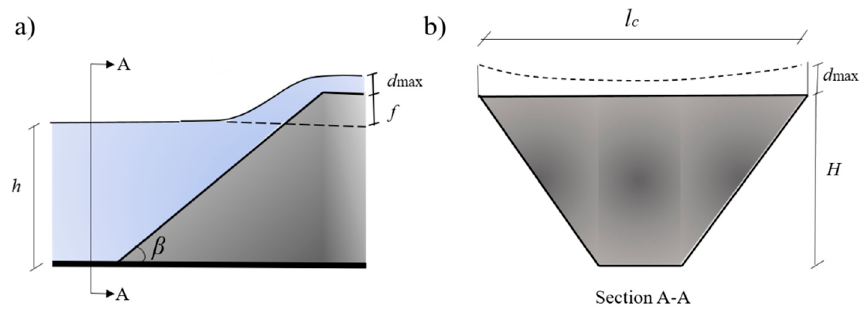
Figure 3. Definition sketch of the overtopping process with the input parameters for overtopping discharge over the dam crest: ( a ) side view, and ( b ) cross sectional view.